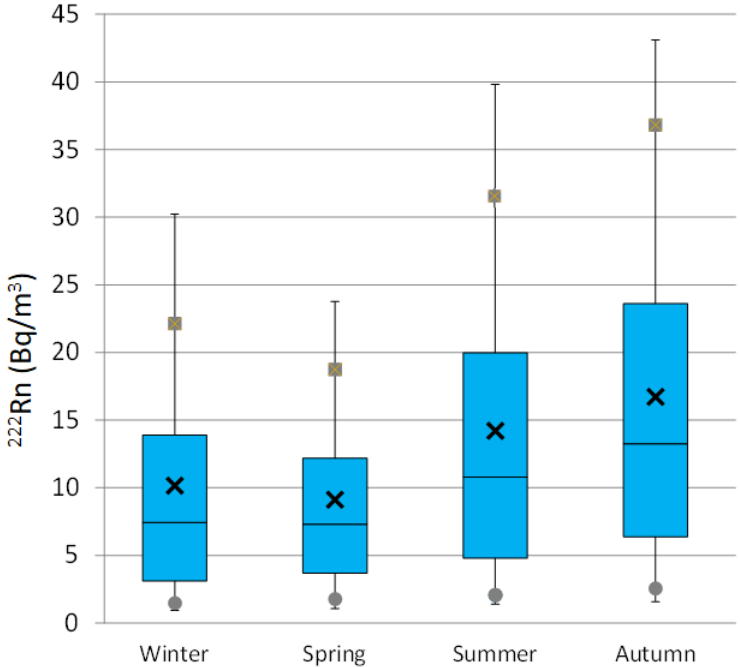
Figure 3. Seasonal box plots of 222 Rn hourly concentrations at Bilbao. The rectangle represents 50% of data (interquartile range from 25th to 75th percentile), the small cross identifies the mean, the continuous horizontal line inside the rectangle identifies the median (50th percentile), the squares and circles identify the 90th and 10th percentiles respectively, and the whiskers extend between the 95th and 5th values.